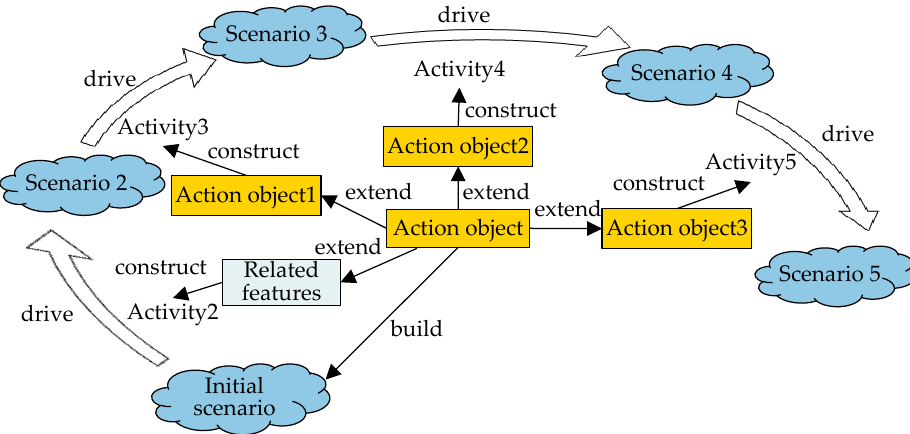
Figure 4. Action relation of the product action object in the scenario analysis.